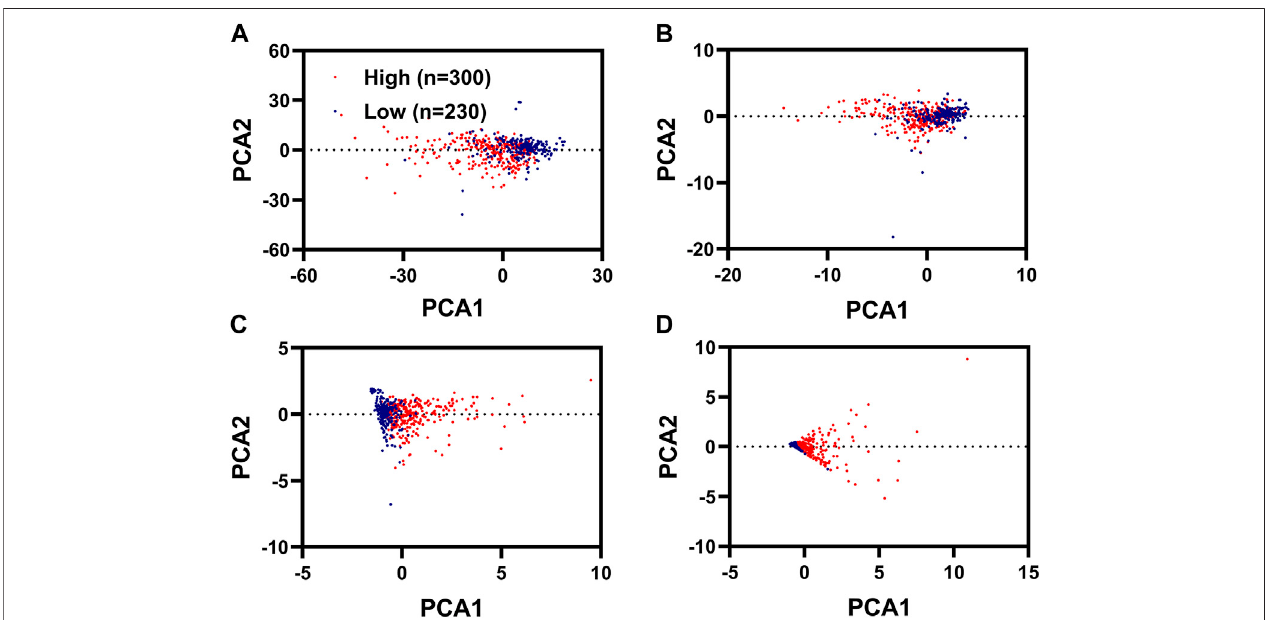
FIGURE 4 | PCA analysis for KIRC with different risk scores. PCA plots displayed the distribution of patients with renal cancer with high risk scores and low risk scores based on 746 FR-DEGs fi lterer by differentially expressed analysis (A) , 26 FR-DEGs fi ltered by Spearman correlation analysis (B) , 4 FR-DEGs fi ltered by K-M analysis and univariate Cox regression analysis (C) , two FR-DEGs fi ltered by multivariate Cox regression analysis (D) .